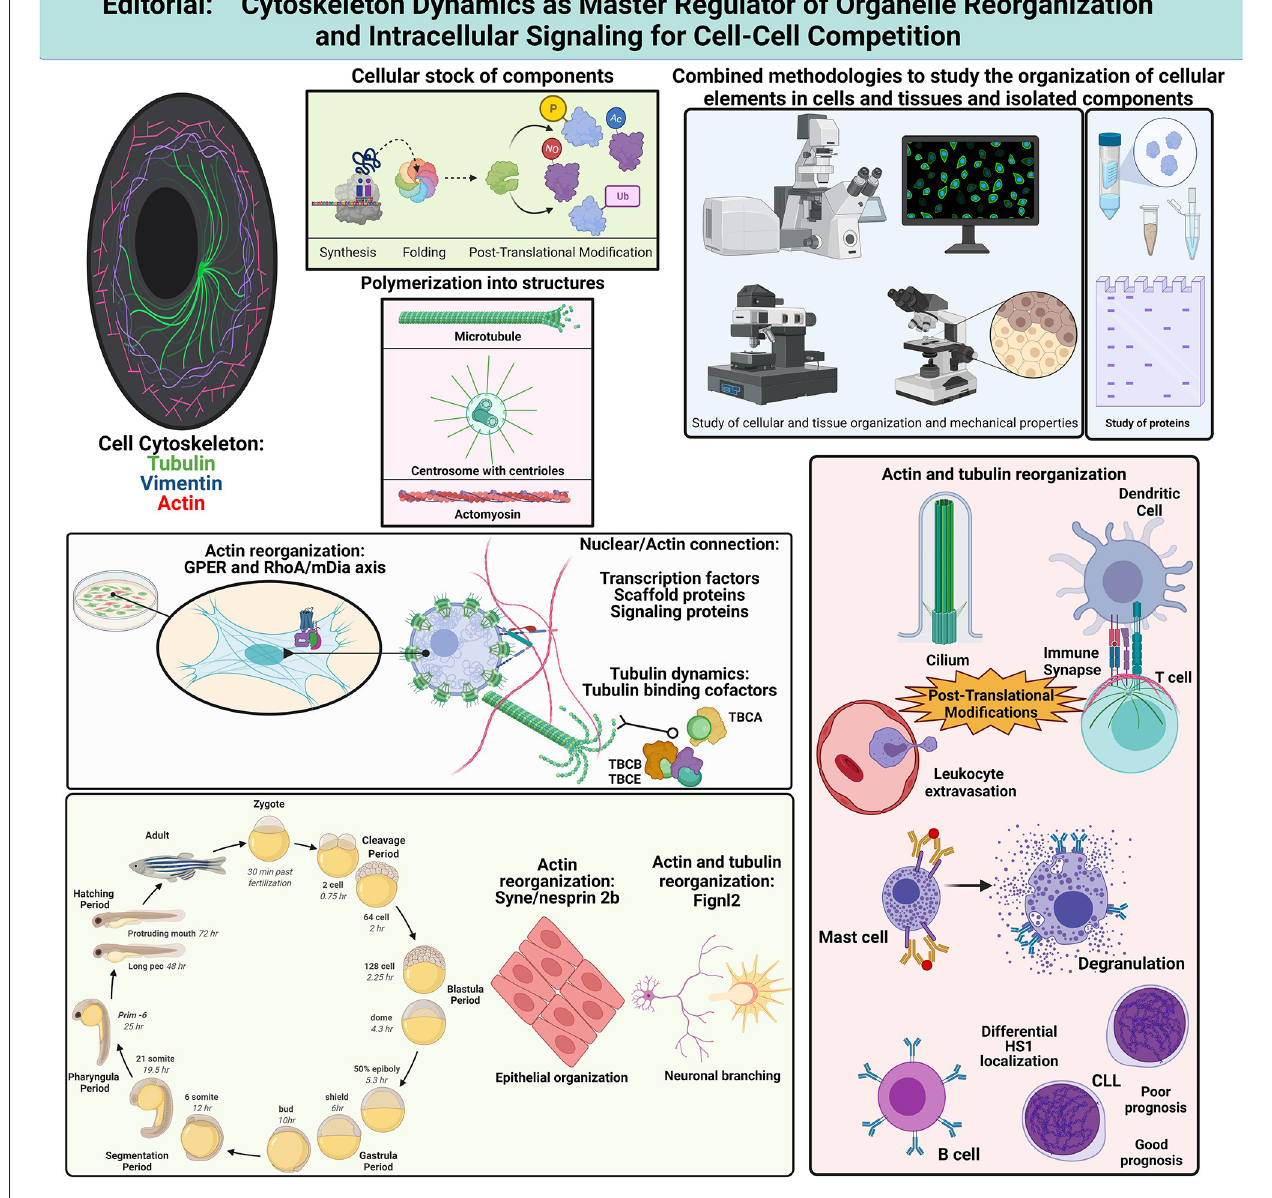
FIGURE 1 | It summarizes the concepts and findings described in the collection of articles pertaining to the Research Topic published in Frontiers in Cell and Developmental Biology, 2021. Created with BioRender.com. Ac, acetylation; CLL, chronic lymphocytic leukemia; Fignl2, fidgetin-like 2; GPER,